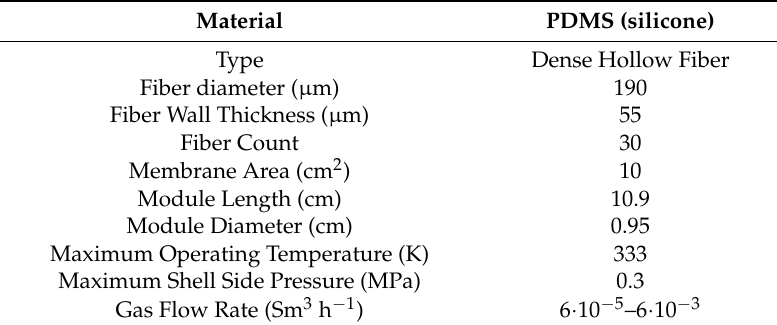
Table 2. Membrane properties and operating conditions.